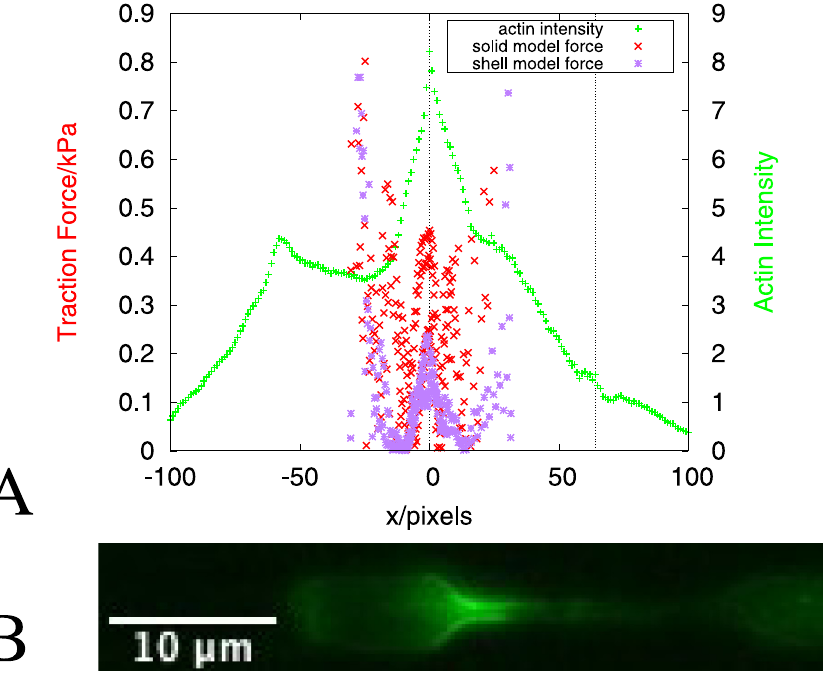
Fig 8. A. Average actin (LifeAct-GFP fluorescence) intensity (green + points) at the time point when the nucleus is entering into the constriction (right hand y -axis). The actin intensity is the mean intensity over the width of the channel at each pixel position. This is then renormalised by the average intensity for each cell and aligned with the start of the constriction at x = 0. The average is taken over 83 cells. The red × points are the absolute values of the y components of the traction force from the solid model (Fig 4B) and the purple ✳ points are the absolute values of the y components of the traction force from shell model (Fig 6B). The vertical dotted lines indicate the start and end positions of the constriction. B. Representative experimental image showing the actin